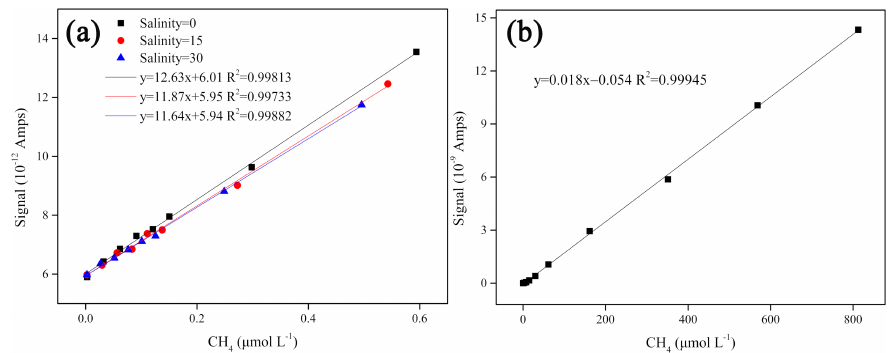
Figure 4. ( a ) Fitting curves using the CH 4 concentration as the abscissa and signal values as the ordinate under different salinities (0, 15, and 30) at 20 °C. The black, red, and blue curves represent the fitting curves at salinities of 0, 15, and 30, respectively. ( b ) Fitting curve for high CH 4 concentrations of standard samples at 20 °C.